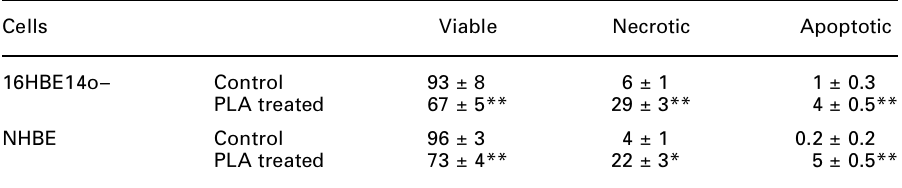
Table 1. Effect of poly- L -arginine on necrosis and apoptosis of airway epithelial cells Cells